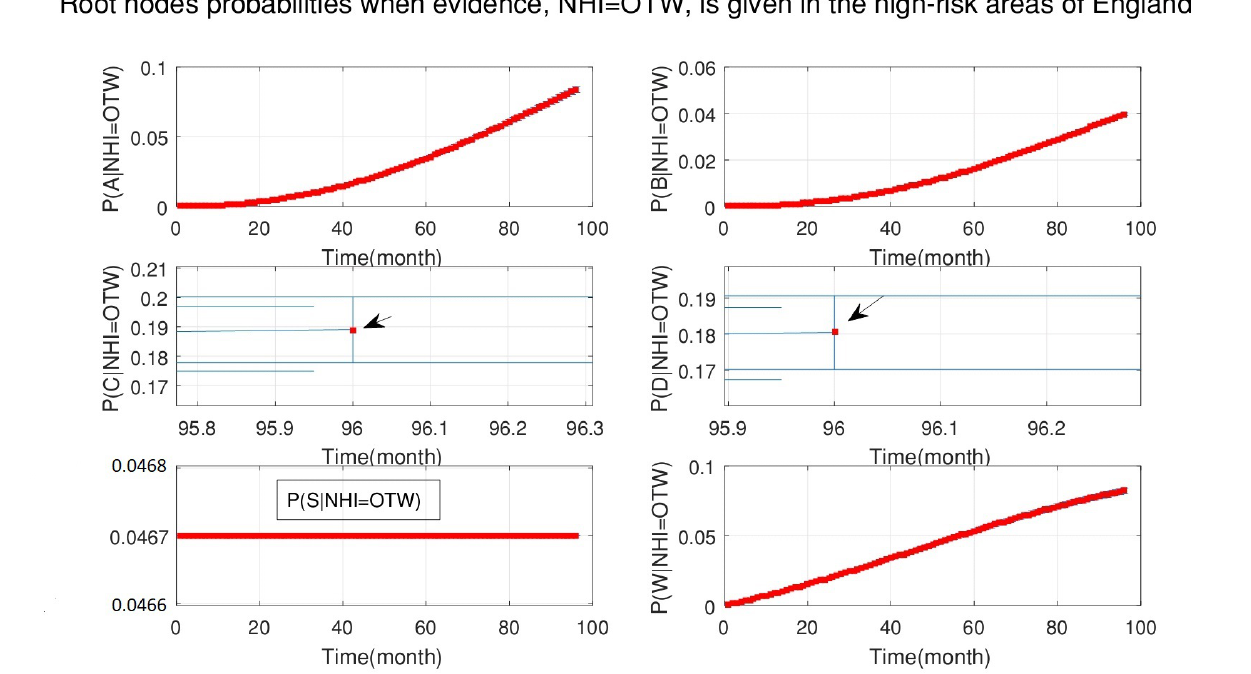
Figure 6. The probabilities of all root nodes (A is the age of cattle, B is the badger density, C is the manure storage, D is the stock density, S is the silage fed and W is the number of purchased cattle) when the evidence, officially TB free status withdrawn (OTW), is added to the system continuously from 2008 to 2015 (bottom-up inference for diagnosis). This figure is a copy of Figure 5 with a clearer view of the middle plots. The middle plots indicate that the probability of manure storage is higher than stock